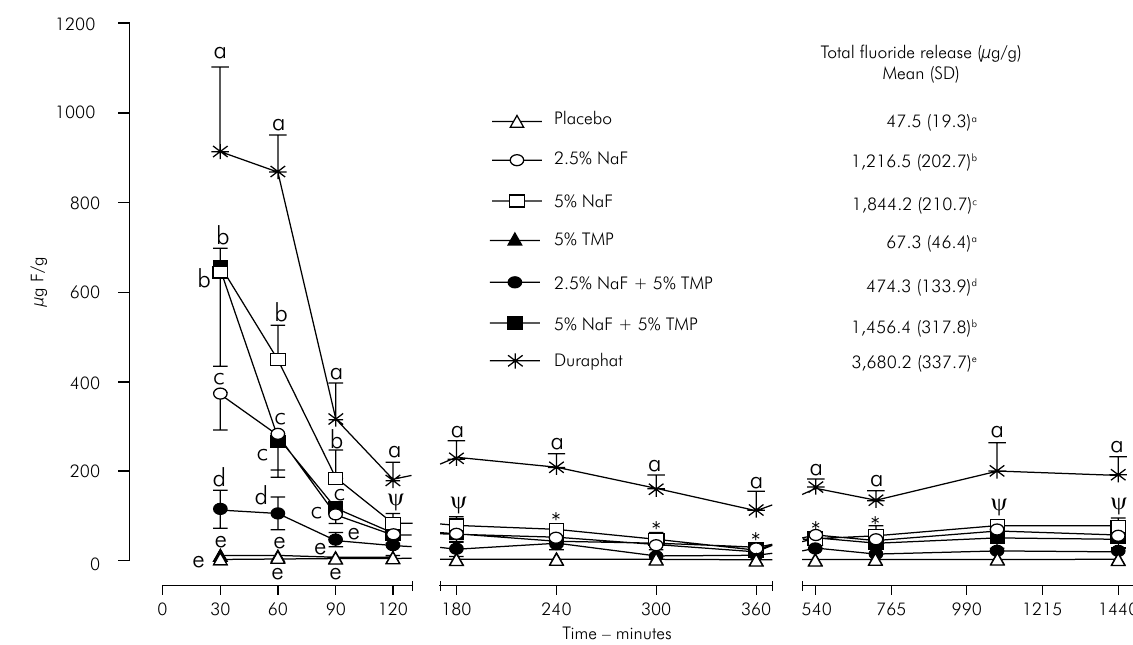
Figure 1. Time-course of the release of fluoride from varnishes into artificial saliva (24 h). Vertical bars indicate standard error of the mean. * p > 0.05. Ψ p > 0.05, except for 5% NaF × Placebo and 5% NaF × 5% TMP (two-way repeated measures-analysis of variance and Student-Newman-Keuls’ test). Cumulative release of fluoride analyzed by one-way analysis of variance/Tukey’s test (p < 0.05). Superscript letters indicate significant differences among the varnishes for each time point, as well as for cummulative data.